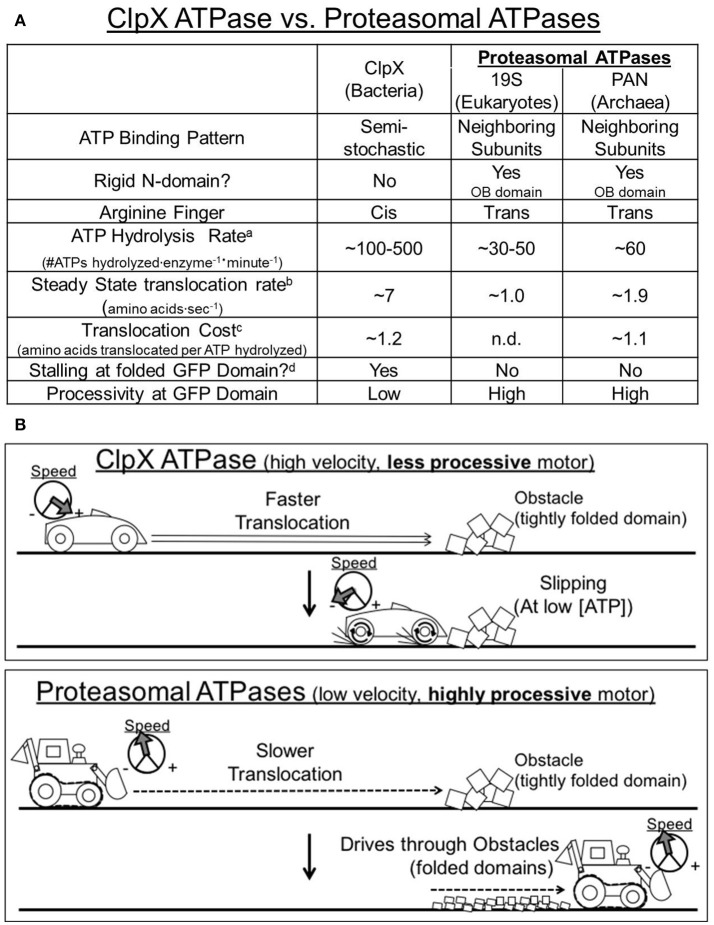
Comparison of the unfolding kinetics for the Proteasomal ATPases vs. ClpX. (A) Summary of ClpX and the proteasomal ATPases' unfolding kinetics taken from experiments performed in this manuscript as well as by other groups (cited in main text). Footnotes: aATP hydrolysis rate in the absence of substrate. bSteady state translocation rates are taken from mean unfolding rates with non-stalling substrates. cTranslocation cost is calculated as the rate of steady state translocation on a non-stalling substrate, divided by the ATPase rate of the enzyme on that same substrate. dStalling is defined as <5% of max unfolding rate at 50% max ATPase activity (Nager et al., 2011). (B) Working model: ClpX ATPases resemble a higher velocity, less processive motor that is prone to slipping. ClpX translocates rather quickly along a loosely folded protein domain. However, at low ATP concentrations, ClpX is unable to drive through tightly folded protein domains, and thus undergoes multiple slips and stalls, and can even dissociate from the protein completely. Proteasomal ATPases resemble a lower velocity, more processive motor. The proteasomal ATPases translocate more slowly along a loosely folded protein domain, but even at these lower speeds the proteasomal ATPase is able to drive through more tightly folded domains (i.e., GFP) without significant slipping or stalling.